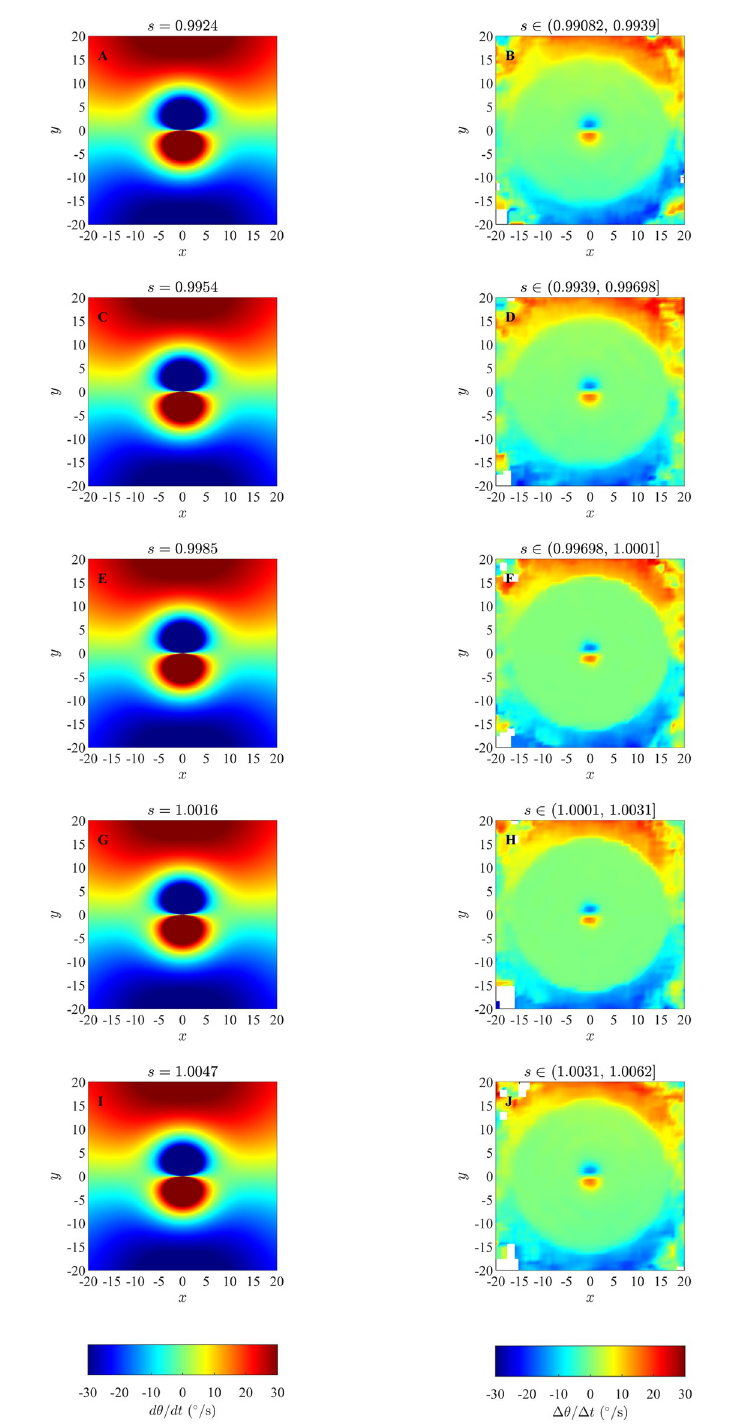
Fig 9. Left column: analytical pairwise turning interactions as prescribed by the ODE model (equation (S3.19)) for groups that move in parallel (item (c) from Table 3). Right column: results obtained via the averaging method. (Derived from simulations with N = 10 individuals over 10000 time